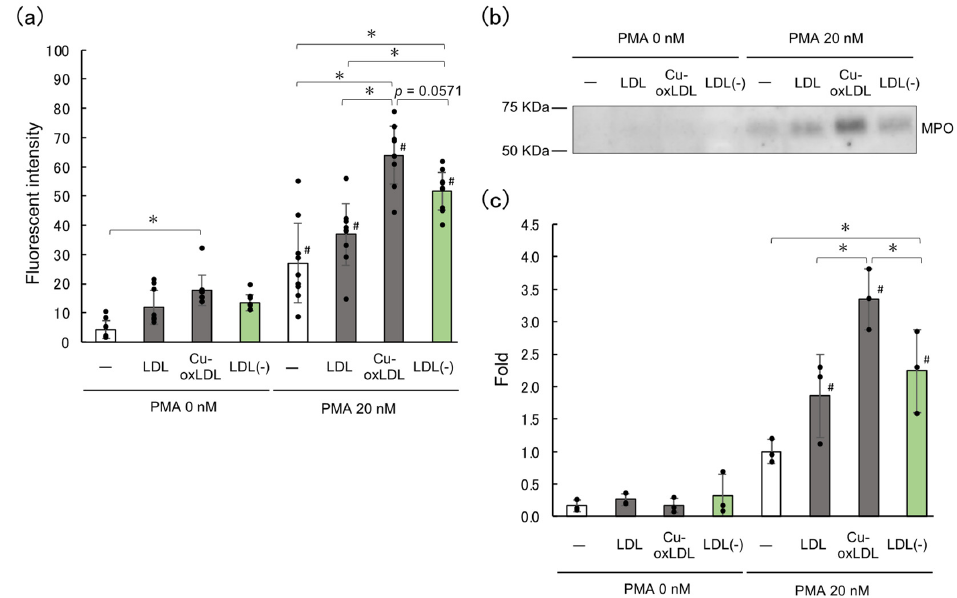
Figure 2. LDL(–) enhances the NET formation of HL-60-derived neutrophils. LDL(–), an electroneg- ative subfraction of LDL, is a fraction that enriches oxLDL in vivo. ( a ) Fluorometric quantification of DNA release. HL-60 cells were differentiated into neutrophil-like cells using 2 μ M AtRA and treated with or without PMA for 30 min. Following that, native LDL, Cu-oxLDL or LDL(–) (final concentration of 20 μ g/mL) was added to and incubated with the cells for 2 h. The DNA released into the medium was digested with MNase for 10 min, and the DNA fragments thus obtained were quantified fluorometrically using SYTOX ® Green. The data represent the mean ± SD from three ex- periments, each carried out in triplicate; each dot represents one datapoint. ( b , c ) MPO in the me- dium was detected in the culture supernatant prepared as described in ( a ) using Western blot. Rep- resentative data from three runs are shown. Band intensity was calculated using ImageJ software ( c ). The data from the three runs are shown. Asterisks indicate statistical significance (* p < 0.05), while sharps indicate statistical significance compared to the corresponding conditions without PMA (# p < 0.05). LDL, low-density lipoprotein; Cu-oxLDL, copper-oxidized low-density lipopro- tein; LDL(–), electronegative low-density lipoprotein; AtRA, all- trans retinoic acid; PMA, phorbol 12-myristate 13-acetate; MNase, micrococcal nuclease; MPO, myeloperoxidase.